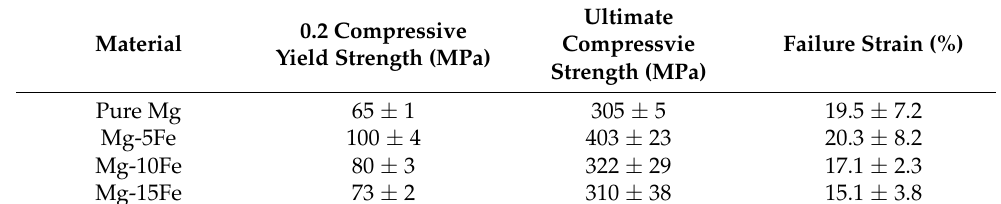
Table 4. Compression properties of pure Mg and Mg-Fe composites.